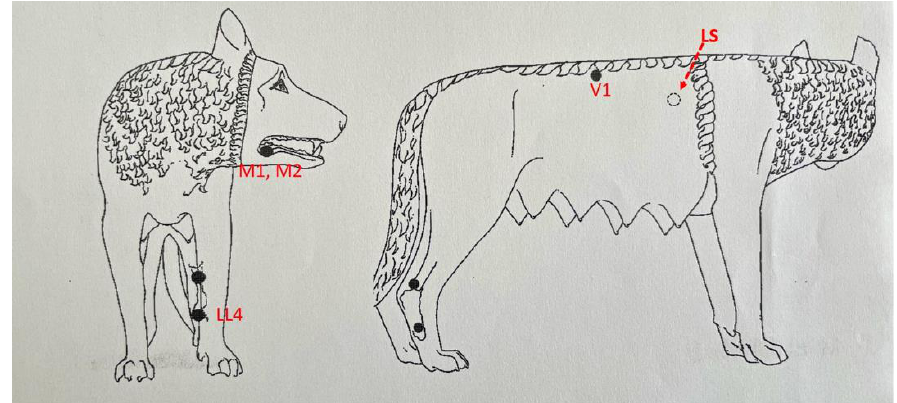
Figure 2. Lupa Capitolina , sampling position of the clay core samples.